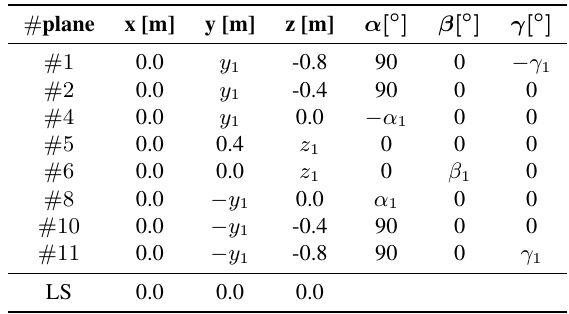
Figure 5. The arrangement of eight selected RP from the calibration environment cf. Figure 3 and the laser scanner in the centre. Table 2. Positions of the RP with respect to the laser scanner